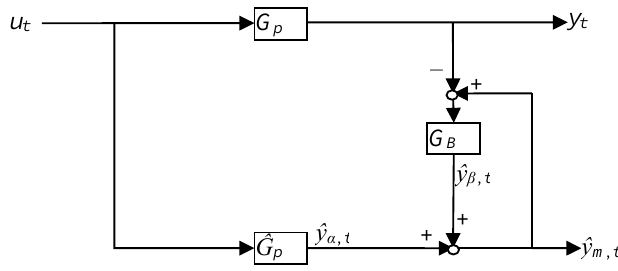
Figure 1. Soft sensor system of interest [1].